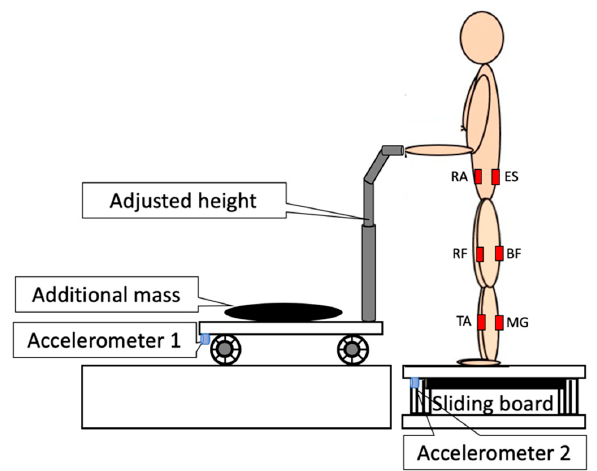
Figure 1. Schematic representation of the experimental setup. Additional mass: an additional 5% body weight or 30% body weight placed on the cart. Accelerometer 1: accelerometer attached to the cart, and Accelerometer 2: accelerometer attached to the sliding board. Red boxes represent the placements of electrodes. RA: rectus abdominis, ES: erector spinae, RF: rectus femoris, BF: biceps femoris, TA: tibialis anterior, and MG: medial gastrocnemius.